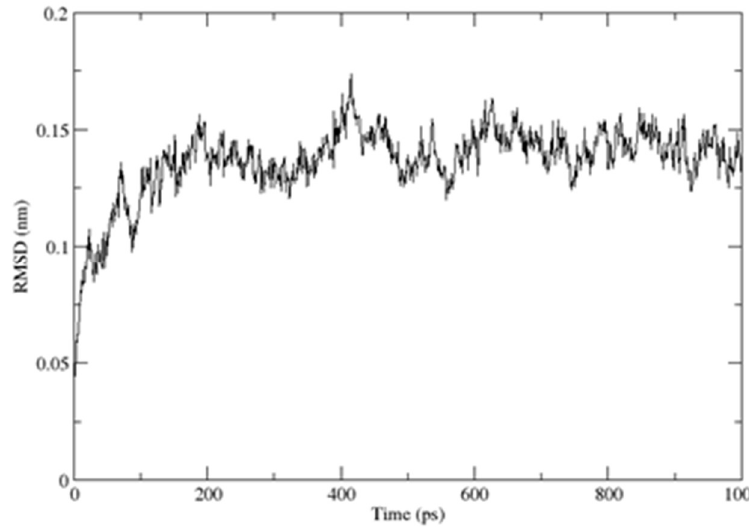
Figure 12. Backbone’s RMSD deviation of the CUBAN domain during the molecular dynamics simulation during time indicated in pico seconds (ps). The structure was deposited in BMRB and PDB data banks with numbers 25722 and 2N5M, respectively [14].